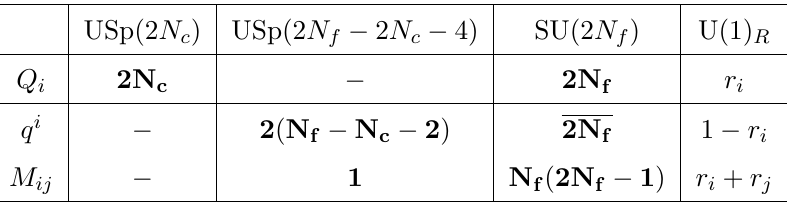
Table 1 . Charges for the USp(2 N c ) theory its USp(2 N f (cid:0) 2 N c (cid:0) 4)